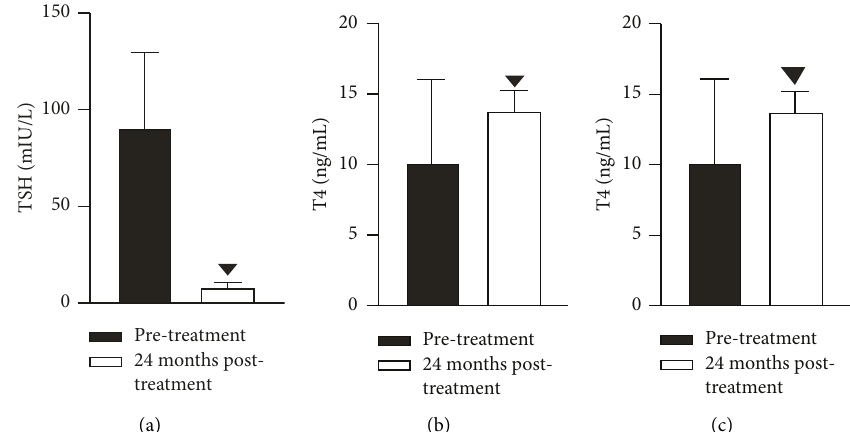
Figure 2: Comparison of changes in serum thyroxine levels in children before and after L-T4 treatment (mean; SD). Note: (a) TSH levels, (b) T4 levels, and (c) T3 levels. ▼ P < 0 . 05 compared with